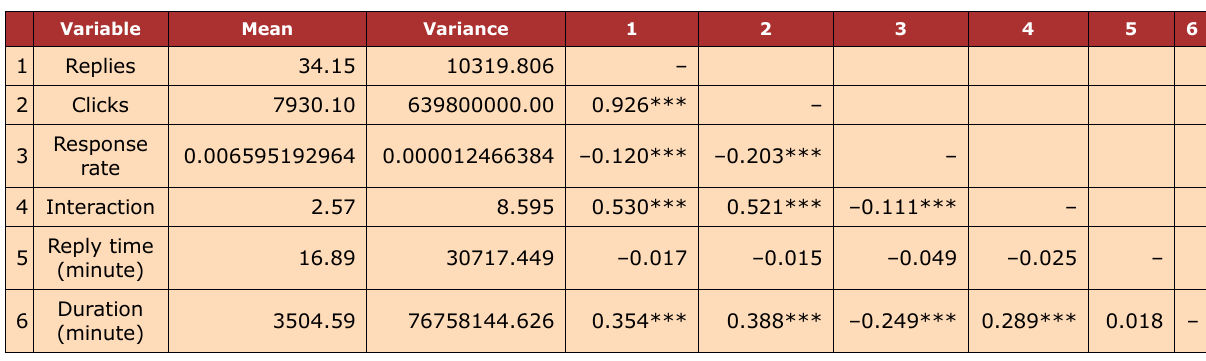
Table 5. Correlation analysis between variables of cognitive attention